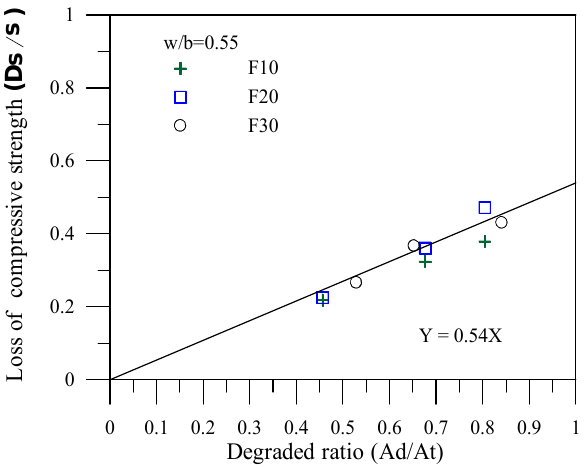
Figure 7. Correlation between the degradation area and the compressive strength loss for the specimens with fly ash.